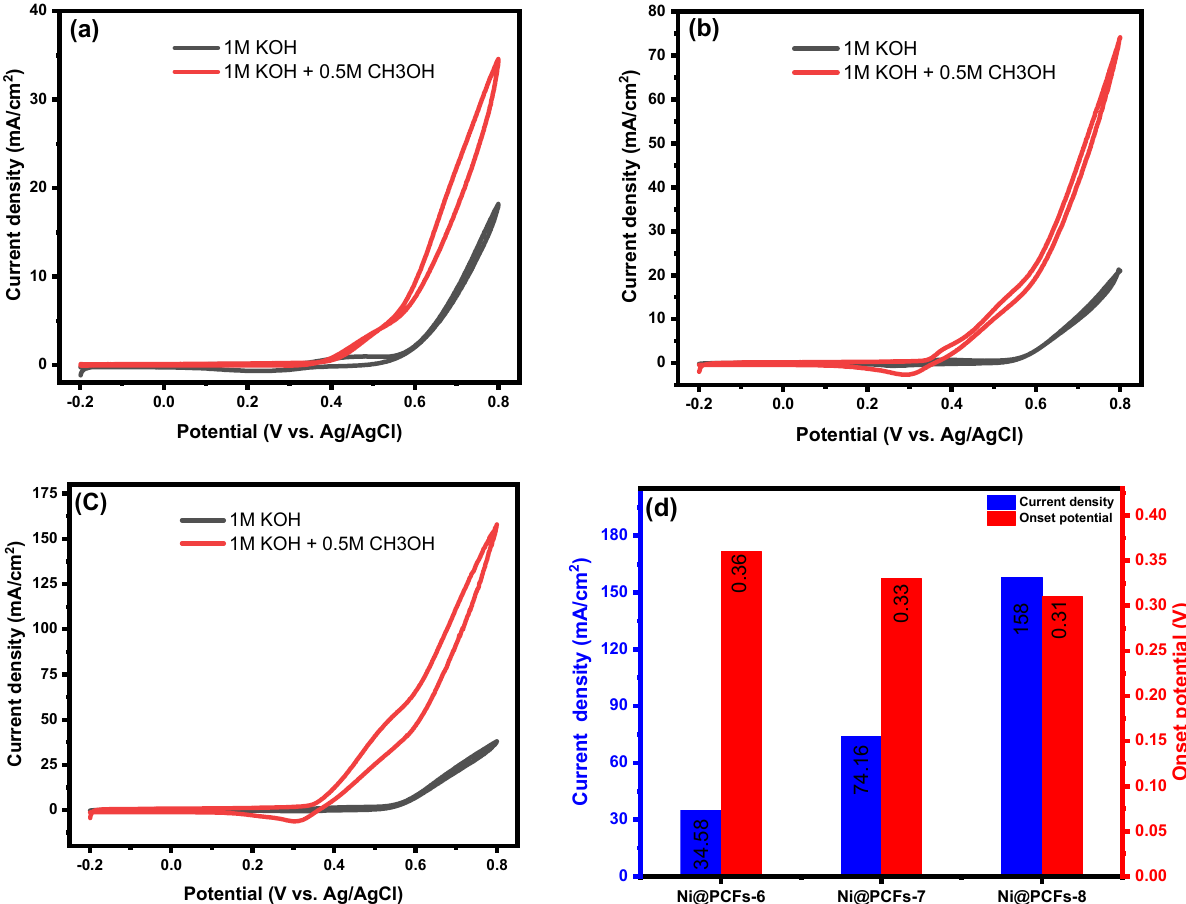
Figure 6. Cyclic voltammograms of the ( a ) Ni@PCFs-6, ( b ) Ni@PCFs-7, and ( c ) Ni@PCFs-8 recorded at 50 mV/s in the absence and presence of 0.5 M methanol in 1.0 M KOH solution and ( d ) steady state methanol oxidation current density and onset potential for the different studied electrocata- lysts.